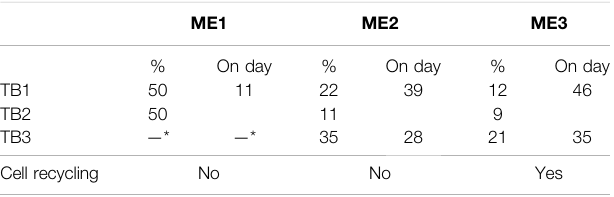
TABLE 1 | Percentages of medium that were exchanged at different time points during fermentations of TB1-3.